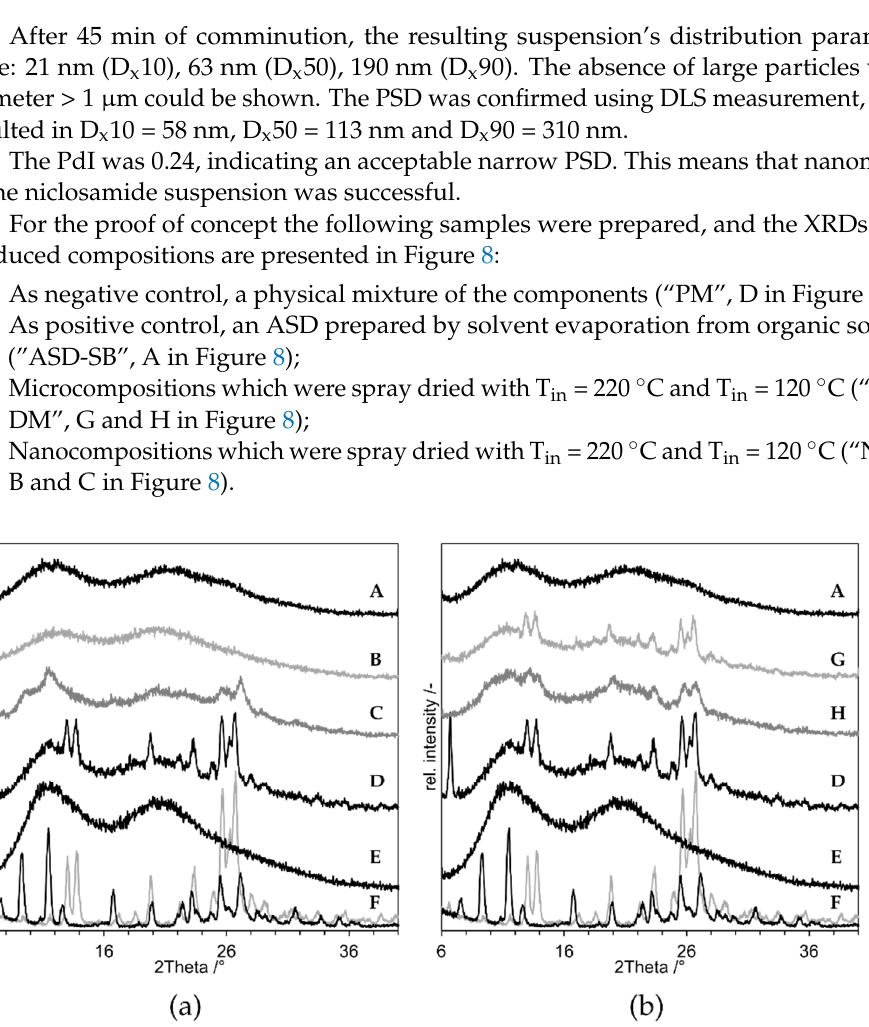
Figure 8. X-ray diffraction results of “proof of concept” experiments with niclosamide. ( a ) the results of the nanocompositions, ( b ) results of the microsuspension are displayed. A: ASD-SB (positive control), B: NDM at 220 °C, C: NDM at 120 °C, D: PM (negative control), E: PVP K25, F: niclosamide anhydrate (grey), monohydrate (black), G: Micro-DM at 220 °C, H: Micro-DM at 120 °C.